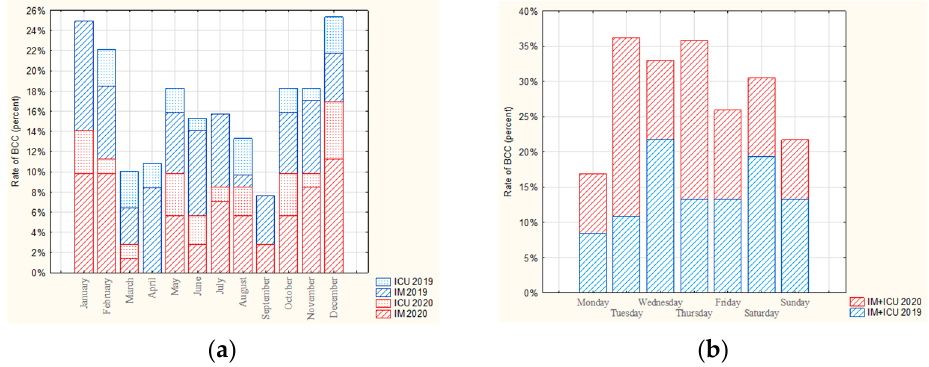
Figure 4. The rate of BCC for IM and ICU in 2019 and 2020 by: ( a ) month, ( b ) day of the week.